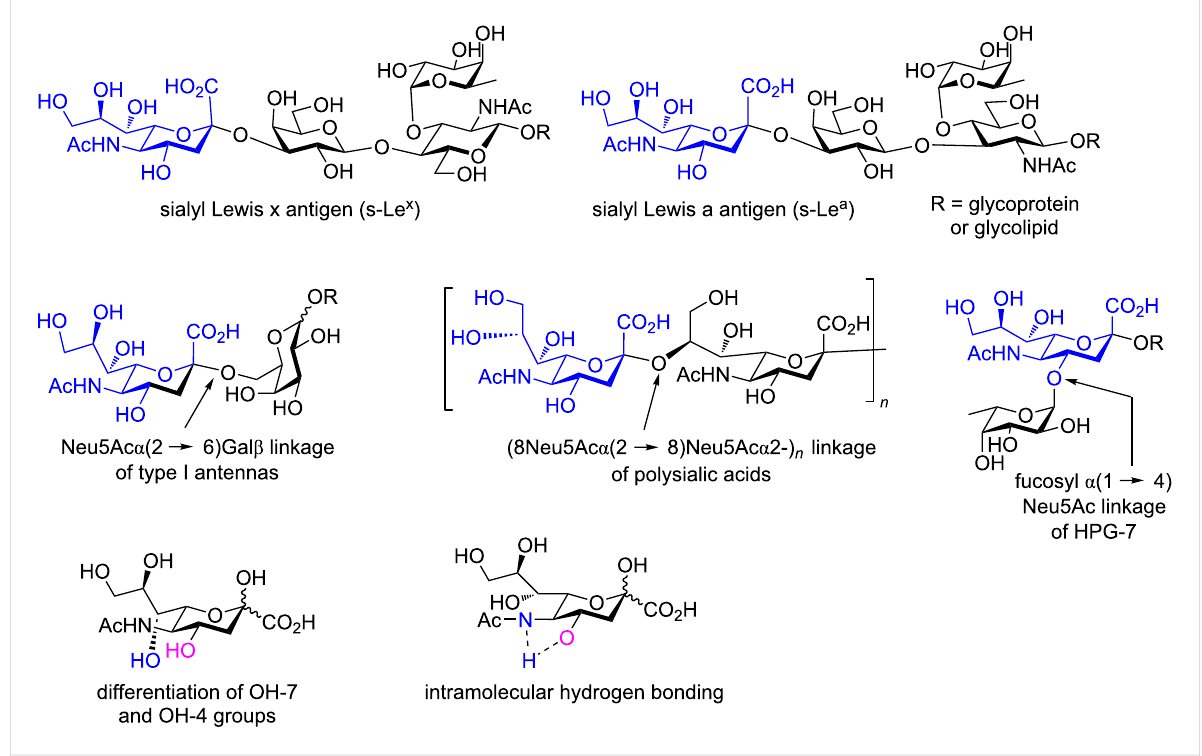
Figure 1: Representative structures of bacterial glycans containing sialic